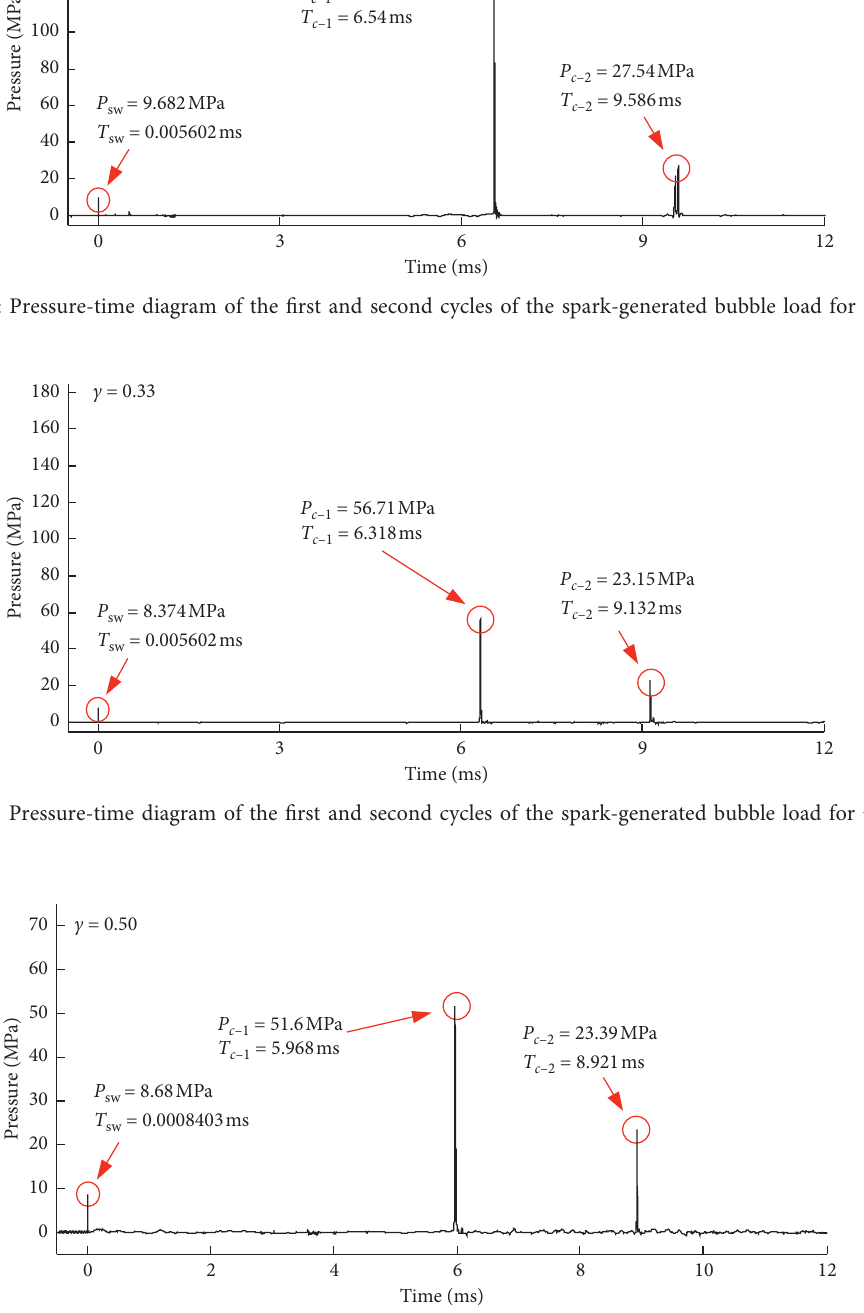
Figure 29: Pressure-time diagram of the first and second cycles of the spark-generated bubble load for c � bubble collapse measured by the Hopkinson bar are valid. (2) The dimensionless distance ( c ) between bubble and hemispheric boundary has an important influence on the morphology and load characteristics of